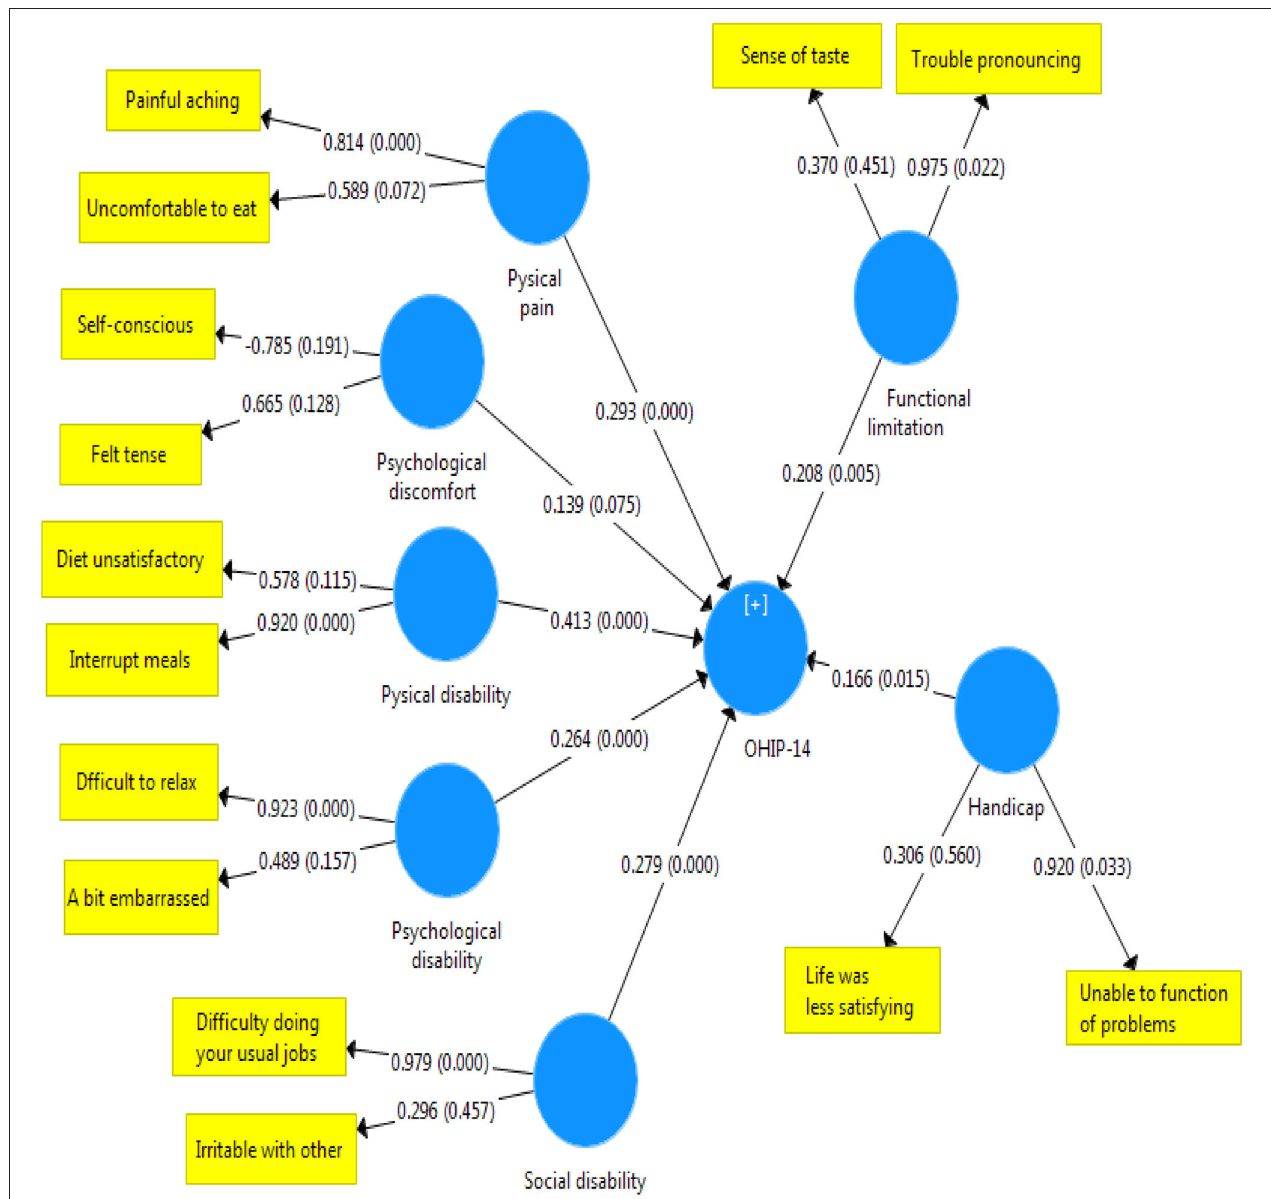
FIGURE 2 | Status and severity of the relationship between scores in the dimensions of OHIP-14 scale and the total score of quality of life related to oral health in narcotic